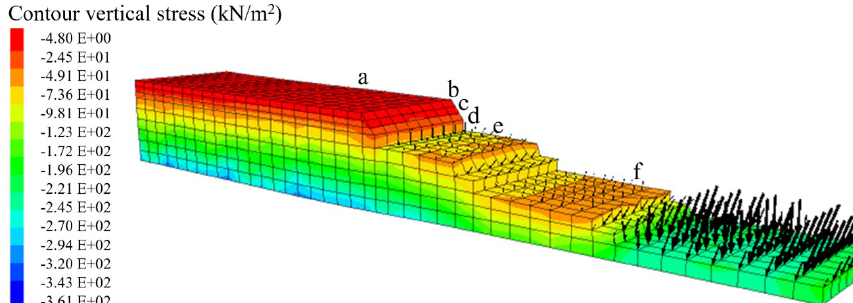
Figure 33. Loading conditions at points a–f, at a time of 50s.